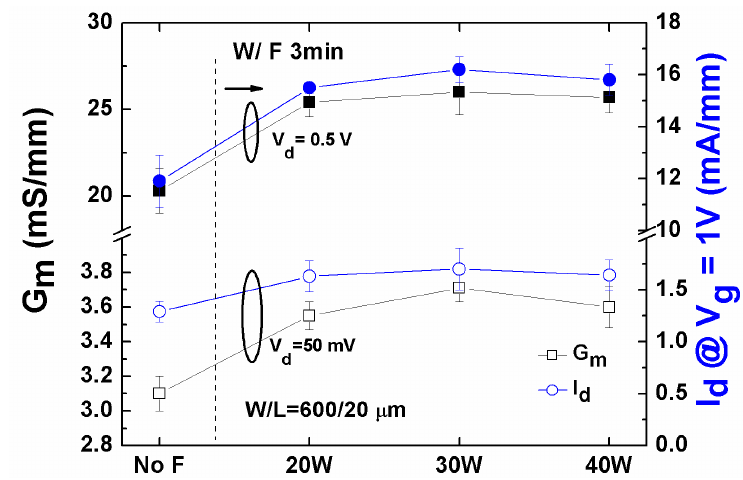
and I as a function of CF m d = 50 mV and 0.5 V). CF d